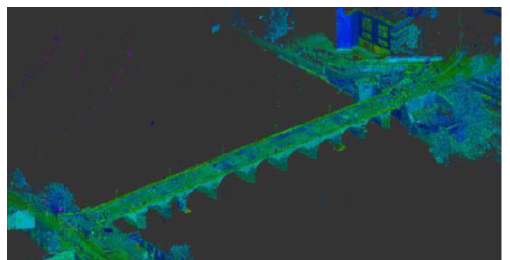
Figure 5: Laser scanning of Azzone Visconti bridge. (Banfi et al. , 2017)